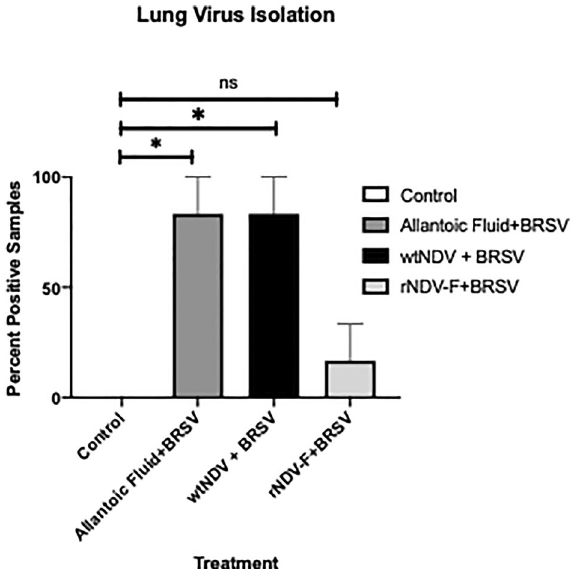
Figure 5. Reduced viral burden in the lungs of rNDV-BRSV F opt vaccinated colostrum-deprived calves. Treatment groups of calves included: unvaccinated, uninfected controls (n = 5); intranasal (i.n.) allantoic fluid vaccinated (mock vaccine control) and BRSV challenged (n = 6); i.n. wtNDV-vaccinated and BRSV challenged (n = 6); i.n. rNDV-BRSV F opt vaccinated and BRSV challenged (n = 6). Lung homogenates were